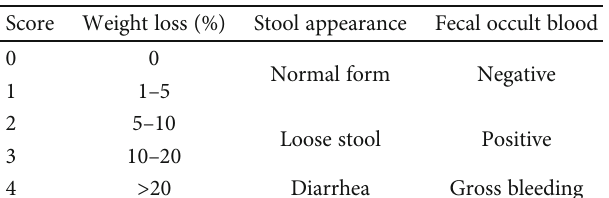
Table 1: Disease activity